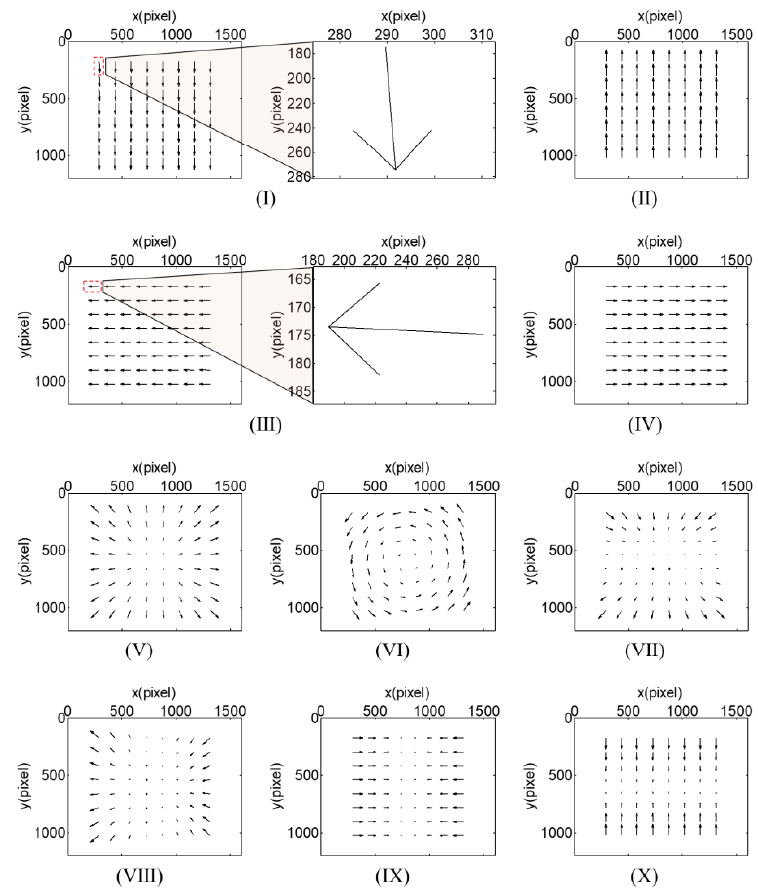
Figure 3. Di ff erent forms of image errors induced by thermal behaviours. Figure 3. Different forms of image errors induced by thermal behaviours. Table 1. Error forms corresponding to each thermal Table 1. Error forms corresponding to each thermal behaviour.